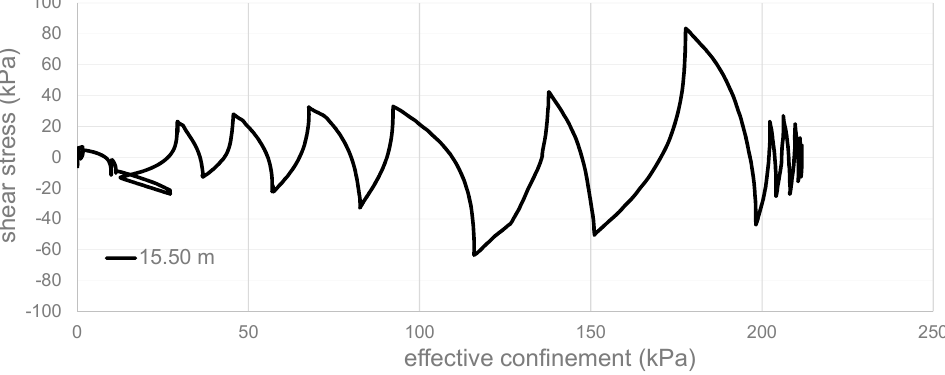
Figure 11. Model-10 m: e ff ective confinement vs. shear stress at 15.50 m depth. Figure 11. Model-10 m: effective confinement vs. shear stress at 15.50 m depth. Figure 11. Model-10 m: effective confinement vs. shear stress at 15.50 m depth. Figure 11. Model-10 m: effective confinement vs. shear stress at 15.50 m depth.